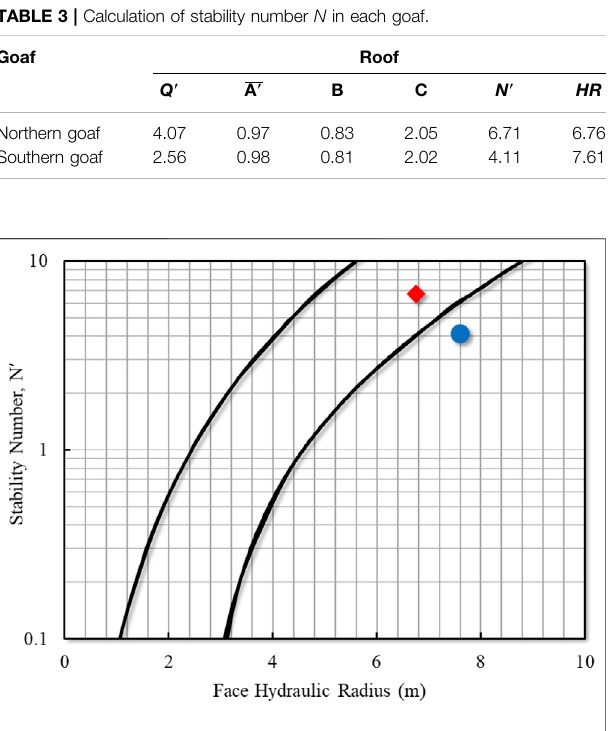
FIGURE 12 | Stability graph of Xiaobeigou